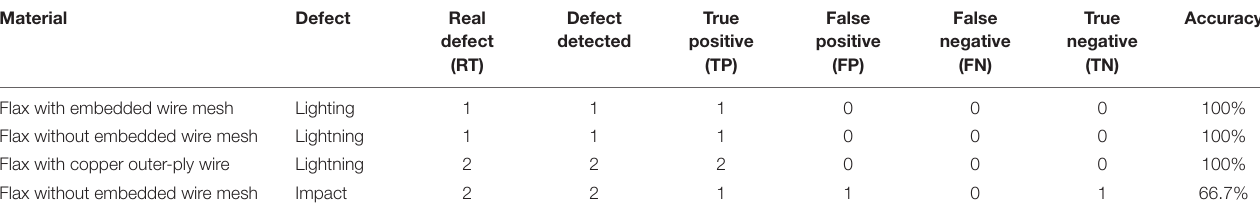
TABLE 4 | Camera FLIR lepton detection